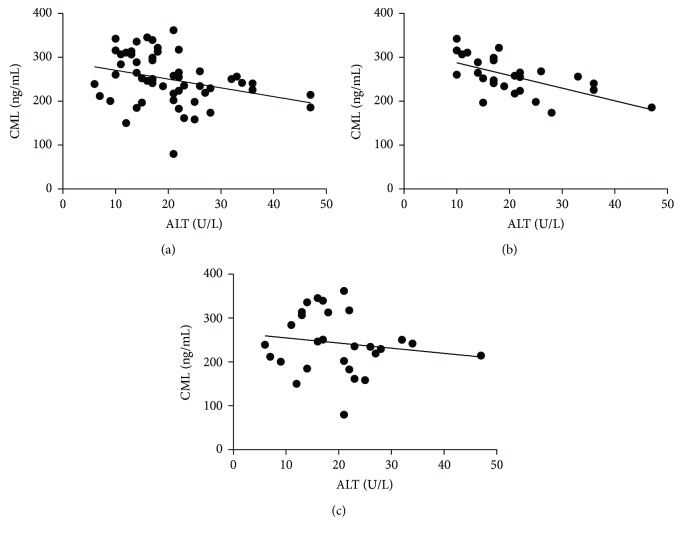
Correlation between CML levels and ALT in individuals with (a) SCAtotal, (b) SCA-HU+, and (c) SCA-HU−. A negative correlation was found between CML and ALT in individuals with (a) SCAtotal (r = −0.35; p = 0.0092), (b) SCA-HU+ (r = −0.61; p = 0.0007), and (c) SCA-HU− (r = −0.14; p = 0.4790). CML: Nε-carboxymethyllysine; ALT: alanine transaminase.